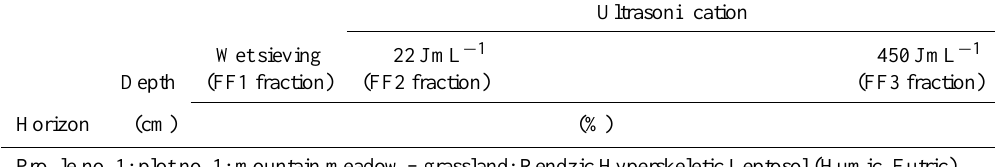
Ultrasonification